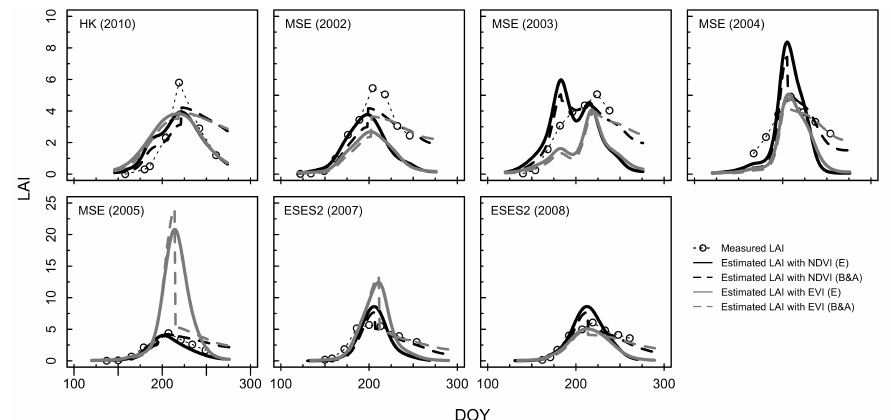
Figure 6. Comparison of the measured LAI (open circles with dashed line) and the estimated LAI using the data from the entire growing season (E, solid line) and the combined two growth phases (B and A, dashed